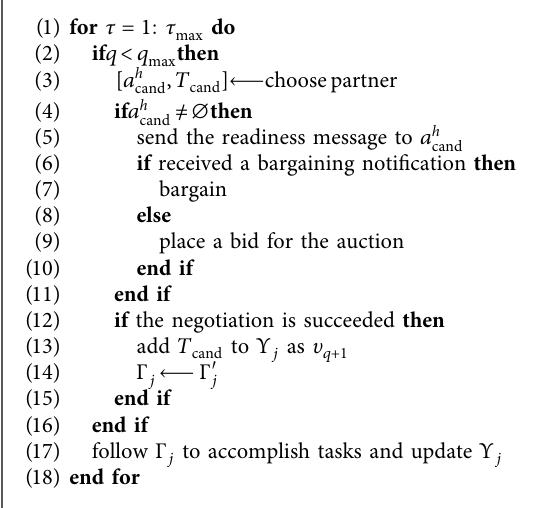
A LGORITHM 4: Decision-making outer-loop algorithm of a gatherer